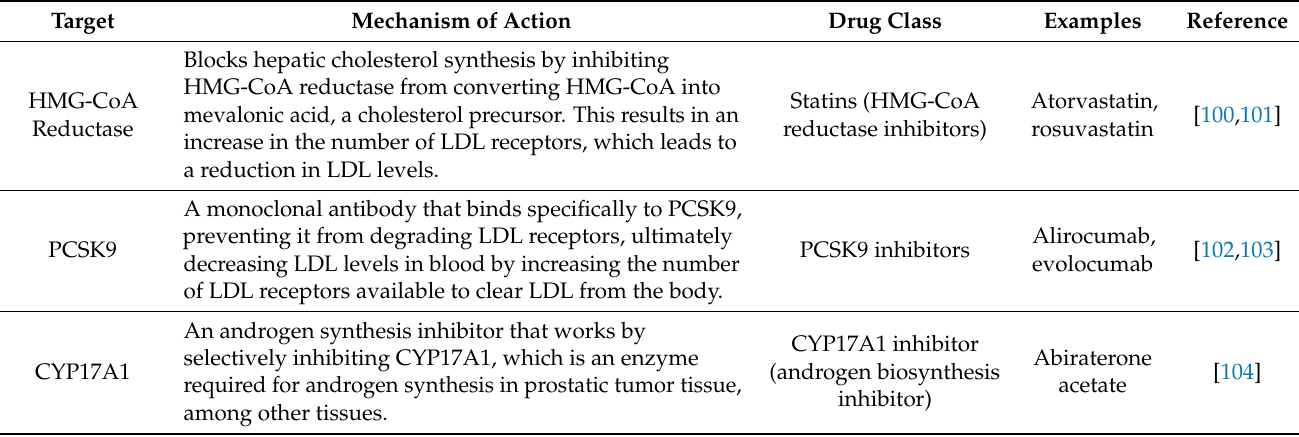
Table 1. Therapies that have been developed due to their effect on cholesterol metabolism by therapeutic target. Target Mechanism of Action Drug Class Examples Reference